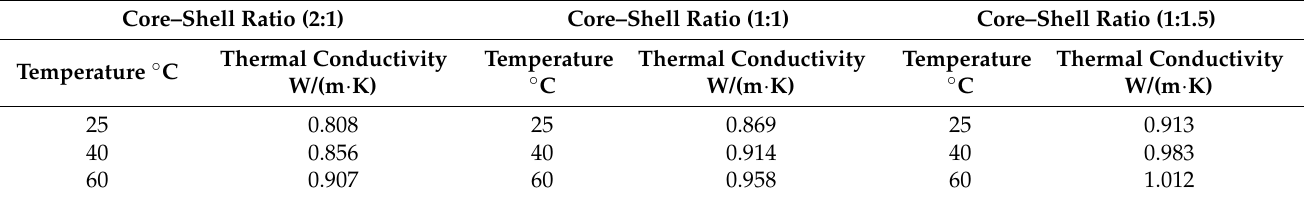
Table 4. Thermal conductivity of